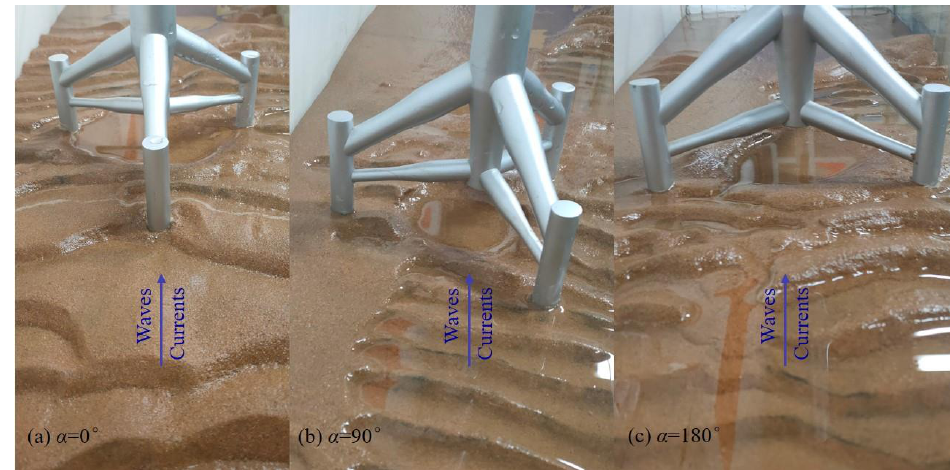
Figure 5. Scour topography around tripod under different installation angles.